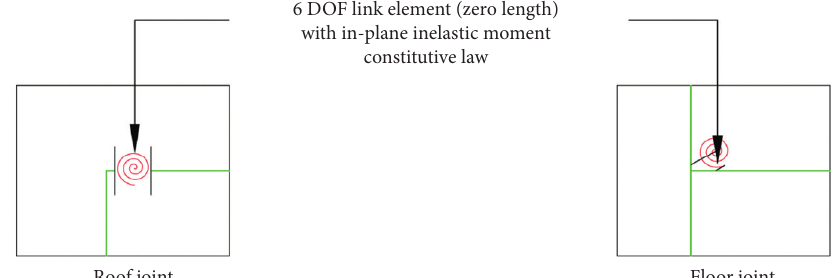
Figure 12: Idealization and modelling of joint shear simulation hinge.